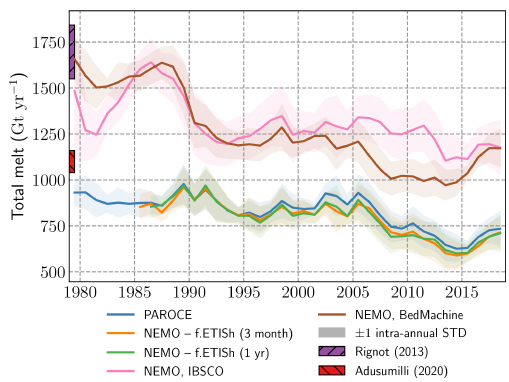
Figure A9. Integrated global Antarctic subshelf melt rates from different experiments (lines) and observational estimates (bars). “PAROCE” is presented in Sect. 5.2. The two “NEMO–f.ETISh” experiments share the same initial bathymetry derived from the initialization described in Sect. 4.3, and feature ocean–ice-sheet coupling (no CCLM 2 ) at distinct frequencies (3 months and 1 year). “NEMO, IBSCO” and “NEMO, BedMachine” are obtained from NEMO stand-alone experiments, with bathymetry and static cavity geometry taken from the International Bathymetric Chart of the Southern Ocean (Arndt et al., 2013) and BedMachine v2 (Morlighem et al., 2020), respectively. Observational datasets are taken from Rignot et al. (2013) and the steady state of Adusumilli et al. (2020).